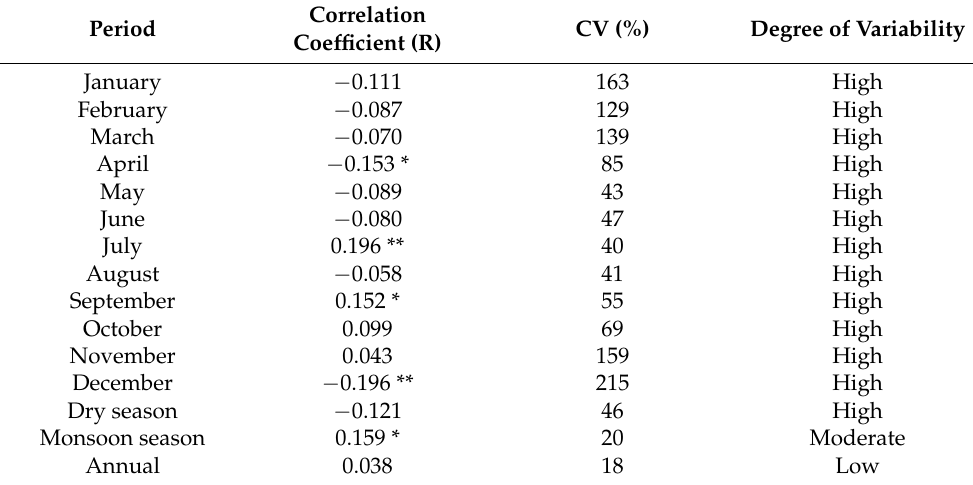
Table 3. Correlation coefficient, MK significance level, CV and degree of variability in rainfall (1978–2017) at Khulna.